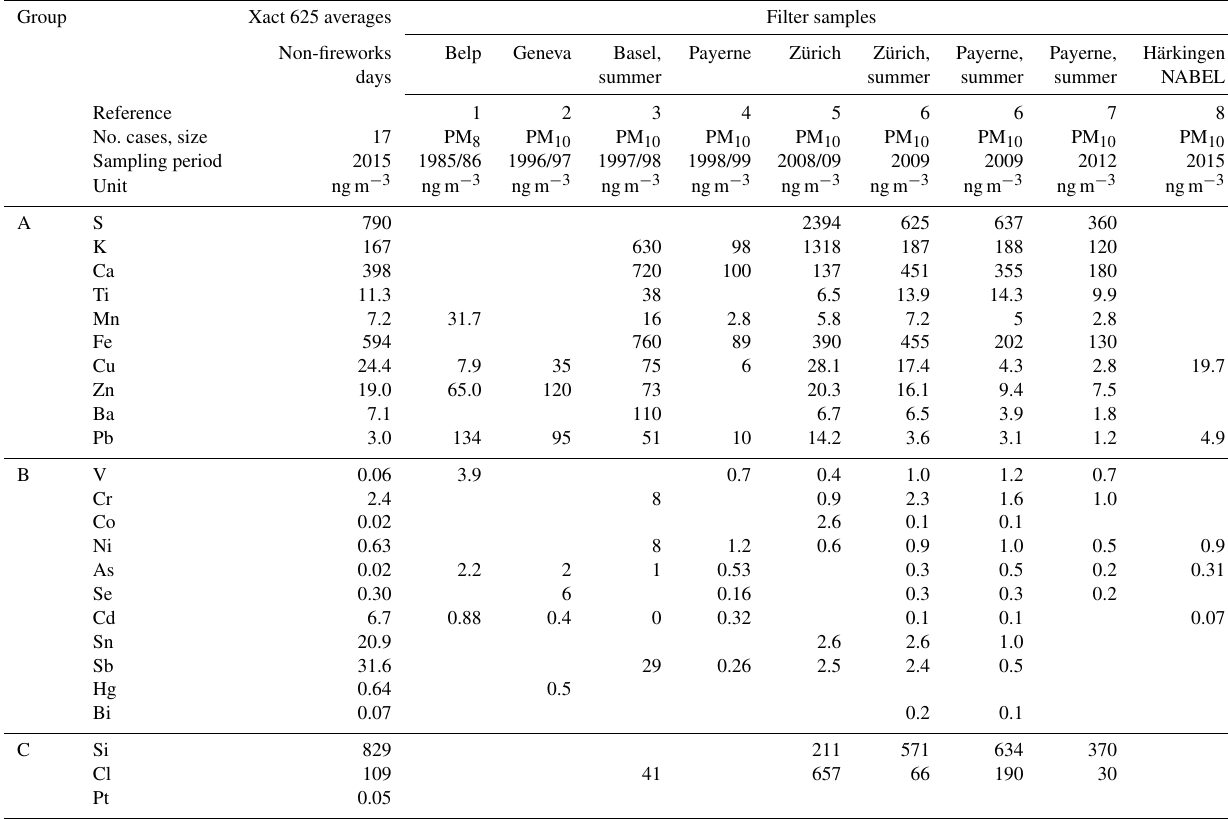
Table 2. Comparison of Xact data with published ICP data of other campaigns. Group Xact 625 averages Filter samples Non-fireworks Belp Geneva Basel, Payerne Zürich Zürich, Payerne, Payerne, Härkingen days summer summer summer summer